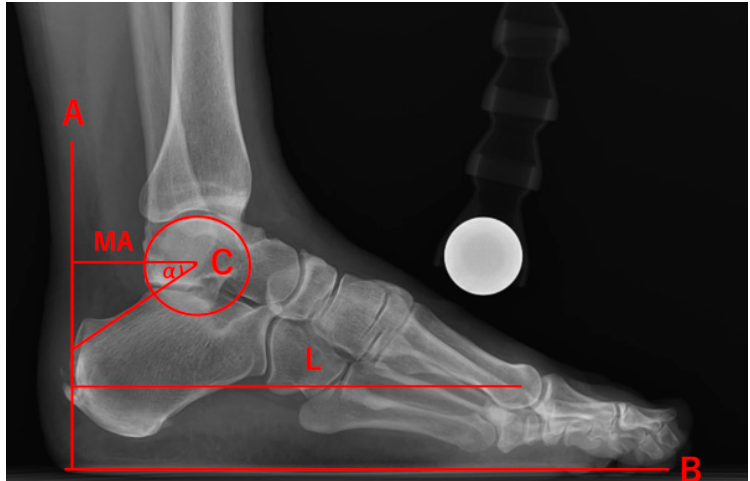
Figure 3. The measurement of the lateral weightbearing radiograph were (A) the centerline of the Achilles tendon insertion, (B) plantar axis, (C) the center of rotation of the ankle, (L) the length of the sole, (MA) the Achilles tendon moment arm ( α ). The angle between the Achilles tendon moment arm and the line connecting the insertion point and the center of rotation.